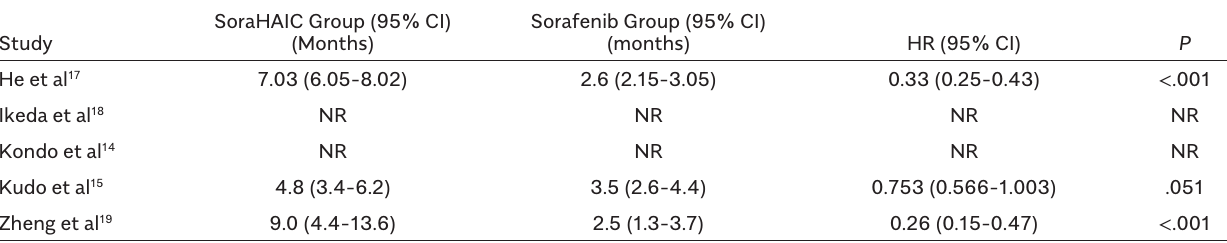
Table 3. The Median PFS and HR in Two Groups